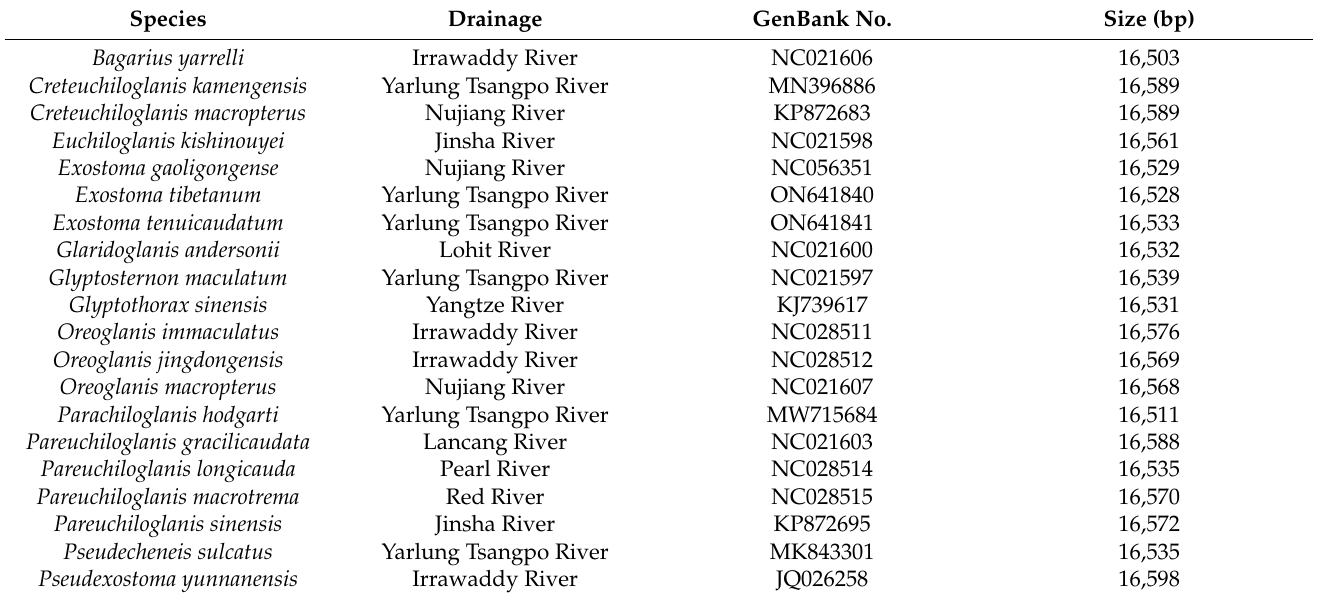
Table 1. Sample distribution information, GenBank accession numbers, and mitogenome size of the species included in the phylogenetic